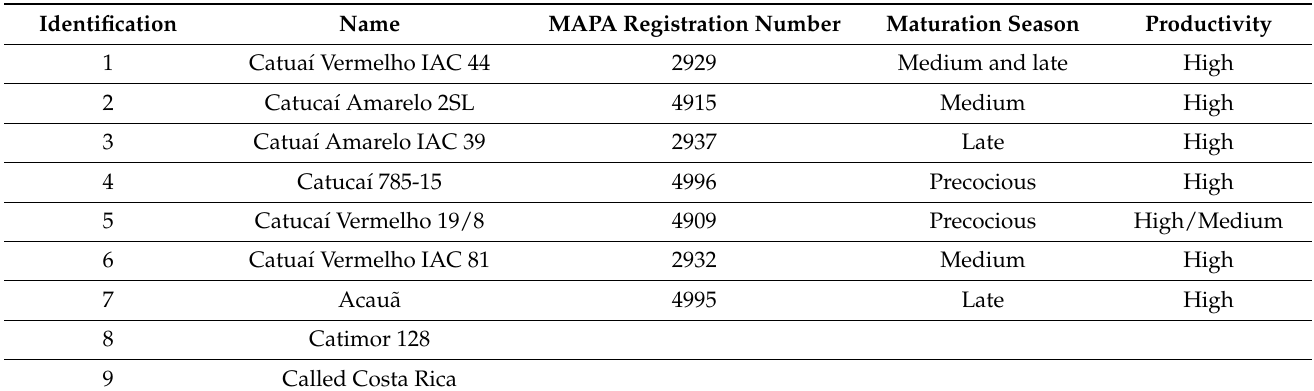
Table 2. Identification of the nine Coffea arabica L. cultivars, grown in the Gorongosa Mountain, Gorongosa National Park. Sofala,